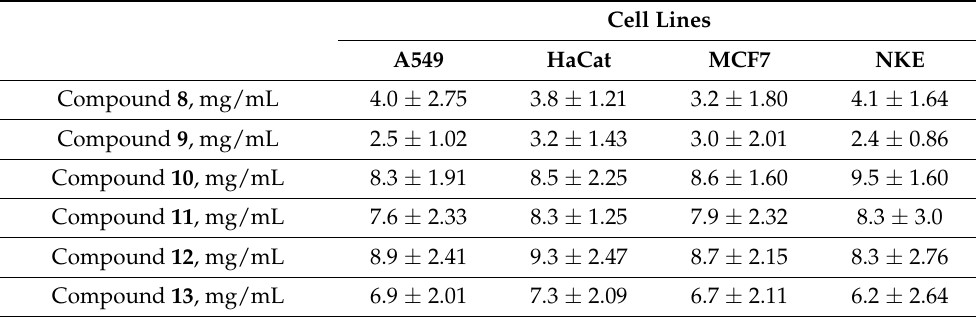
Table 5. IC 50 values (mg/mL) obtained from the analysis of pyridine carboxylic acid derivatives by the MTT method for different cell lines with an incubation of 72